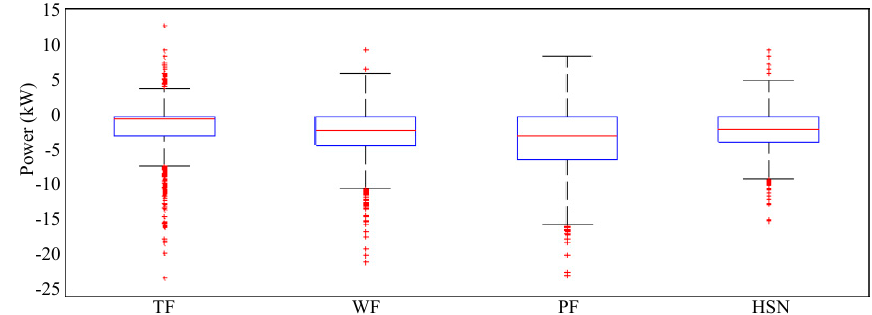
Figure 21. Box-whisker plot of response errors under single sorting criterion.